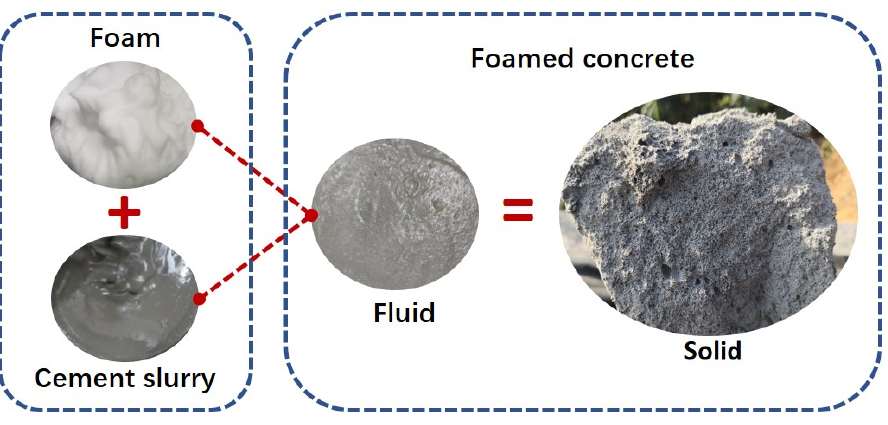
Figure 1. Production process of foamed concrete.